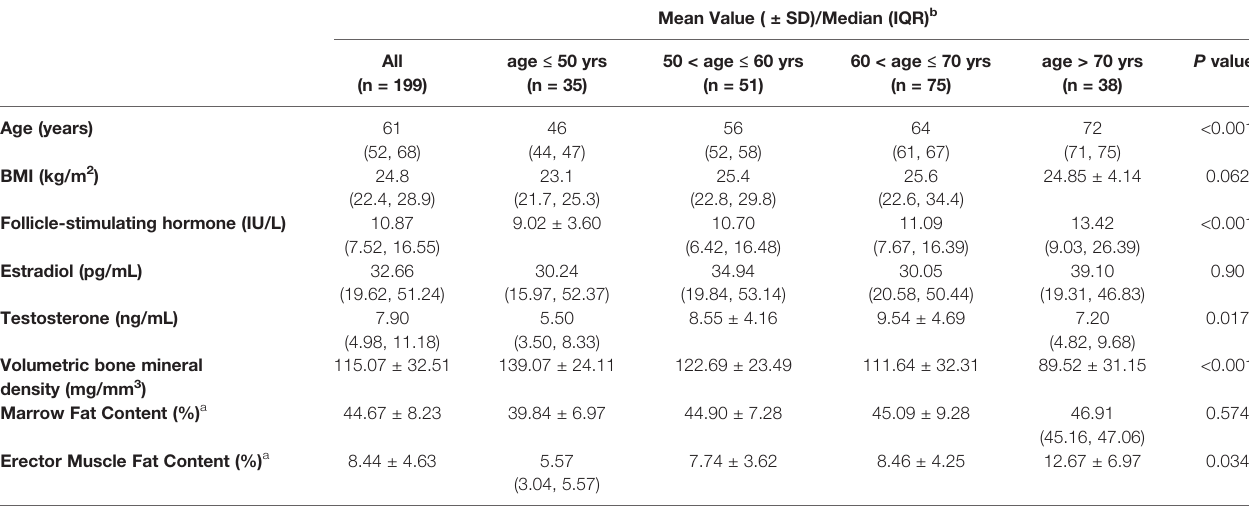
TABLE 1 | Demographic and biologic characteristics of 199 men overall, and of the men at different levels of age.